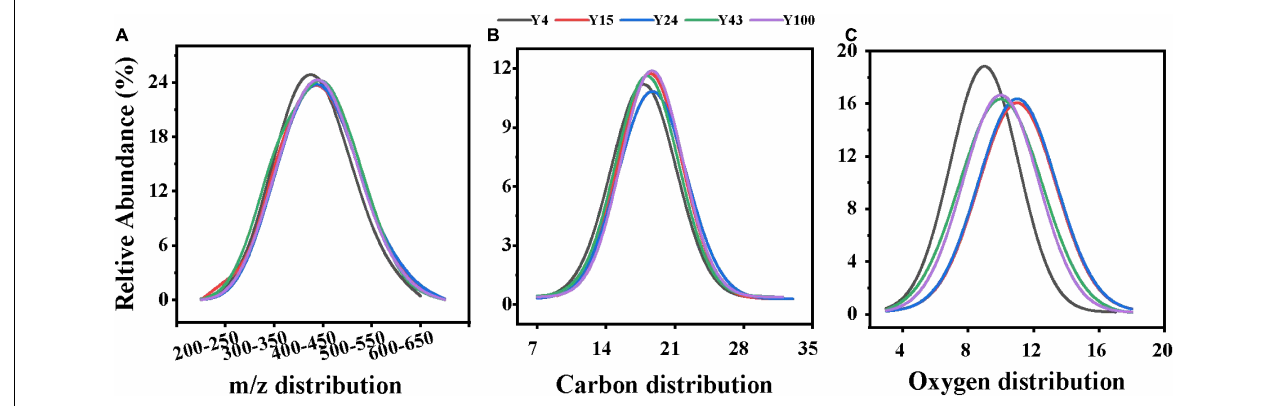
FIGURE 2 | The relative abundance of different properties of soil dissolved organic matter (DOM) molecules in Chinese fir plantation stands of different ages: (A) carbon numbers, (B) oxygen numbers, and (C) m / z distribution. A Gaussian function was used to fit the curves.